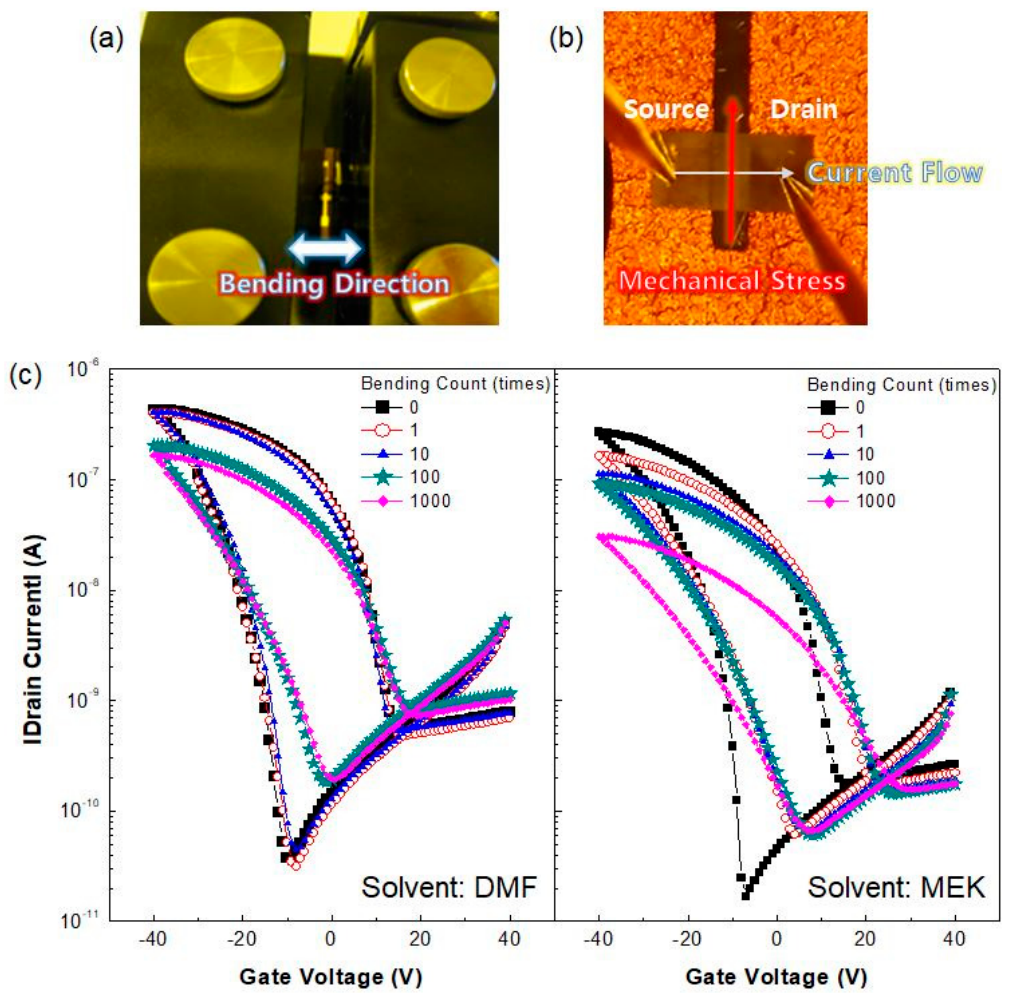
Figure 5. ( a ) Photograph of bending test of flexible Fe-FETs; ( b ) Microscopy image of Fe-FET being evaluated under bending; ( c ) Transfer characteristic curves of flexible Fe-FETs using DMF (left) and MEK (right) solvents before and after various bending cycles.